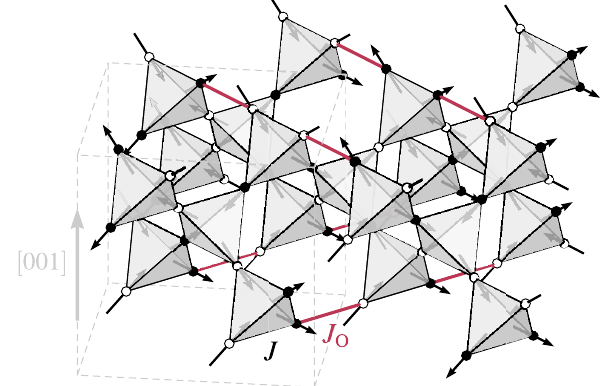
FIG. 2. Phase diagram of [001] thin films of spin ice as a =J [see function of temperature and orphan-bond coupling J O Eq. (2)]. The state at low temperature is either a classical U ð 1 Þ =J > 0 Þ or a classical Z J =J < 0 ). spin liquid ( J 2 spin liquid ( O O Two broad crossovers at T ∼ J and T ∼ j J (dashed lines) O j separate these phases from the high-temperature paramagnet distinct from that of O (PM). For thick films, there is an additional crossover (not shown) where three-dimensional bulk spin-ice behavior is recovered for T ≳ J= log L